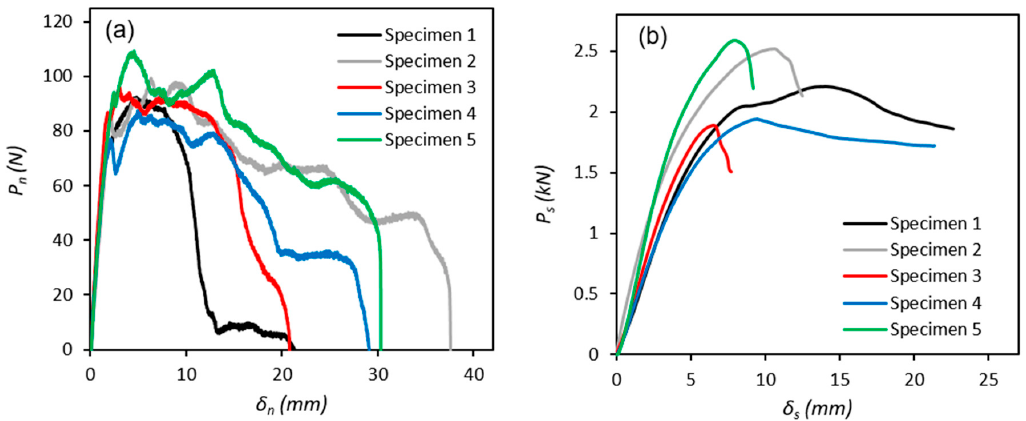
Figure 6. Load-displacement ( P– δ ) responses for five specimens each of ( a ) DCB and ( b ) ENF tests.